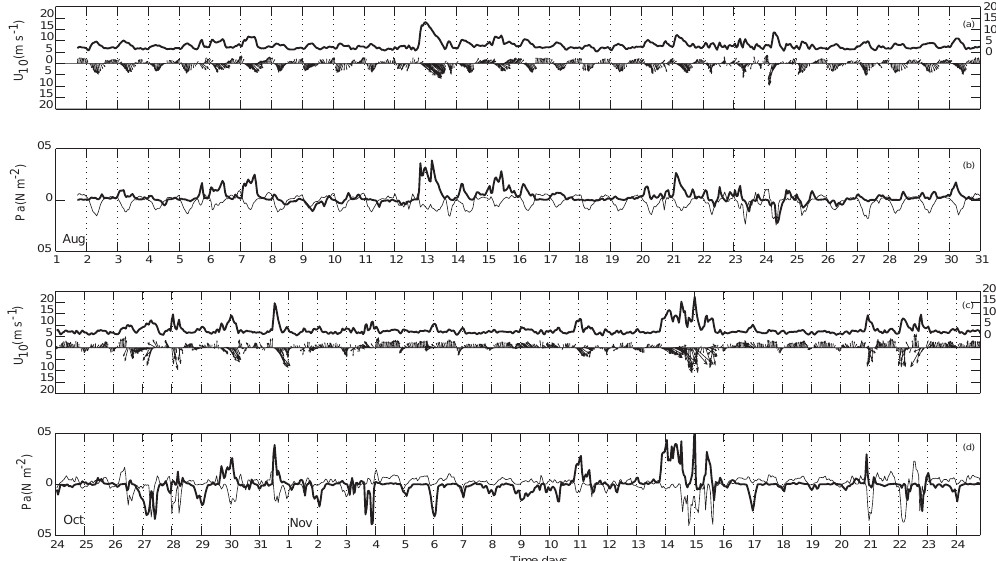
Fig. 2. Wind stick plot and wind stress of hourly filtered wind components data, alongshore (348 ◦ N, thick line), and cross-shore (78 ◦ E, thin line). (a) and (b) first segment (720h covering whole August 2003); (c) and (d) last segment (from 2000h of records to the end from 24 October to 24 November 2003).